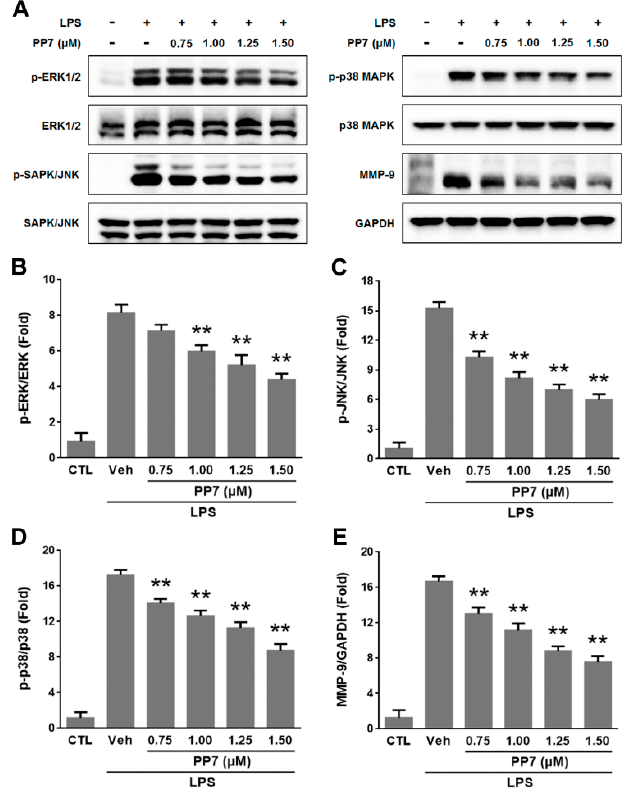
Figure 4. Inhibitory effect of PP7 on the LPS-induced MAPKs and MMP-9 proteins in RAW264.7 cells. Cells were pre-treated for 1 h with or without PP7 at indicated concentrations (0.75, 1.00, 1.25, and